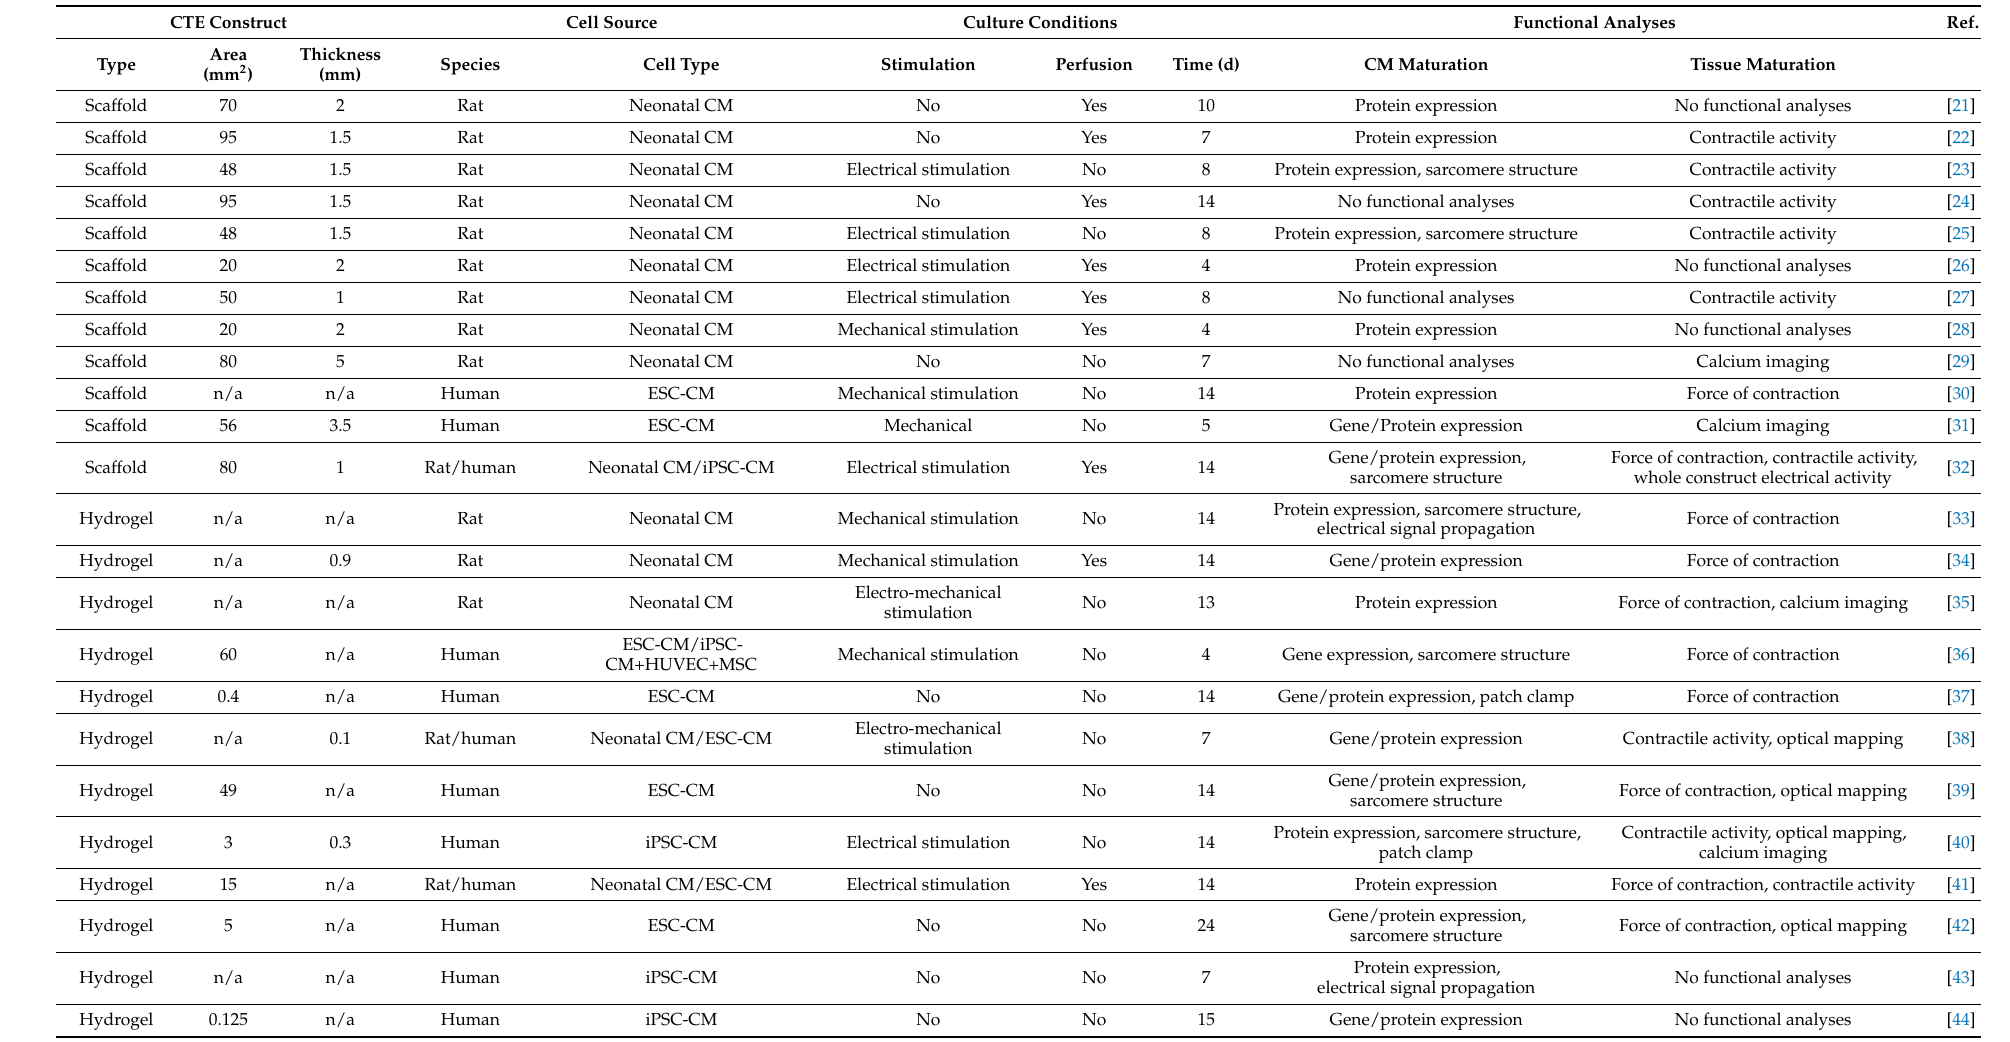
Table 1. Representative studies on